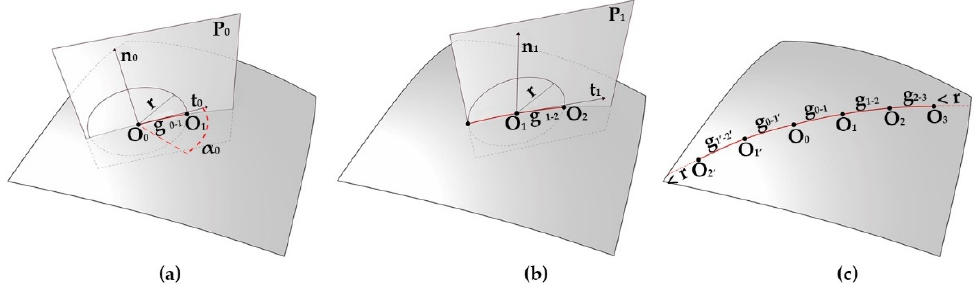
Figure 5. Generation of a geodesic curve from a point and a direction vector: ( a ) First iteration from the origin point; ( b ) Second iteration from the point resulting from the first iteration; ( c ) Resulting geodesic curve.